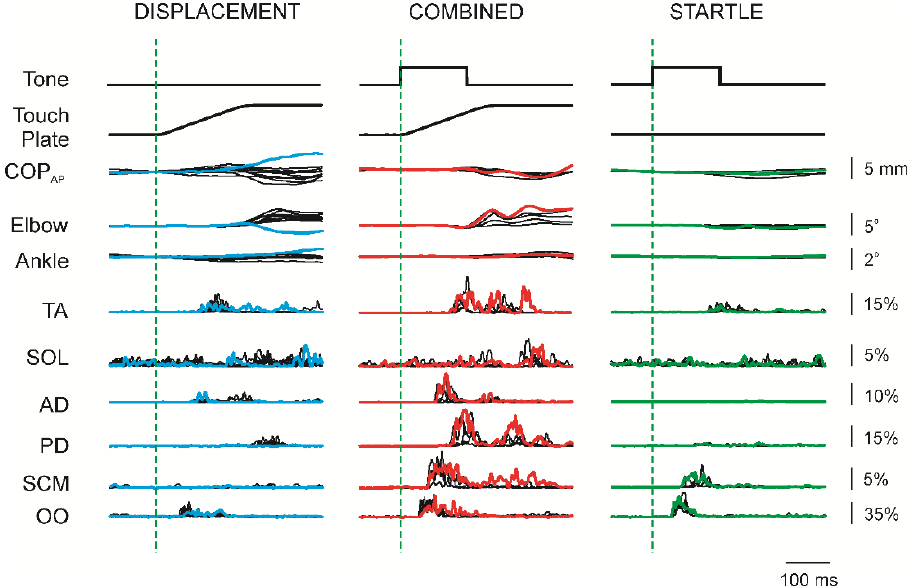
Figure 2. Sample data traces from a single participant who received the COMBINED stimuli after habituating to the DISPLACEMENT stimuli. Each cluster of traces represents the complete series of trials for that stimulus mode, with the coloured traces representing the first trial for that stimulus mode (Blue, DISPLACEMENT; Red, COMBINED; Green, STARTLE). The thin black lines of each cluster represent the subsequent trials. The vertical dashed line is aligned to the onset of the stimuli. Positive deflections in the COP AP traces represent forward, elbow traces represent extension, and ankle traces represent plantarflexion. COP AP , center of pressure anterior–posterior; TA, tibialis anterior; SOL, soleus; AD, anterior deltoid; PD, posterior deltoid; SCM, sternocleidomastoid; OO, orbicularis oculi.